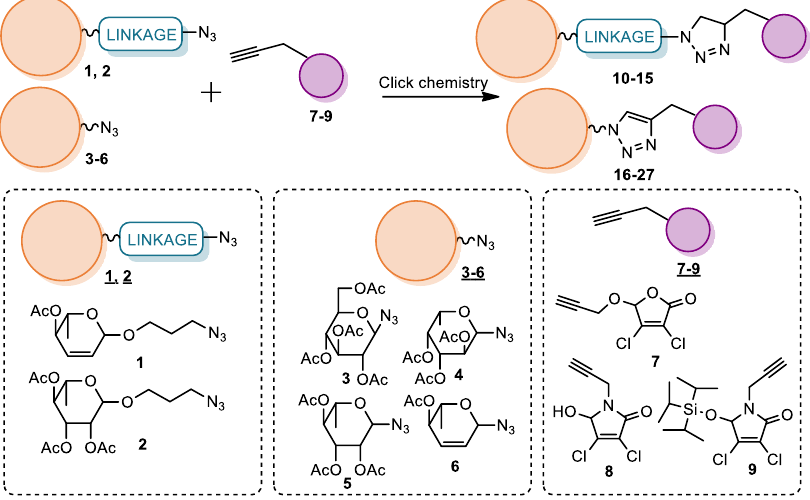
Table 1. Reaction conditions to obtain azide derivatives of sugars ( 1 – 6 ).